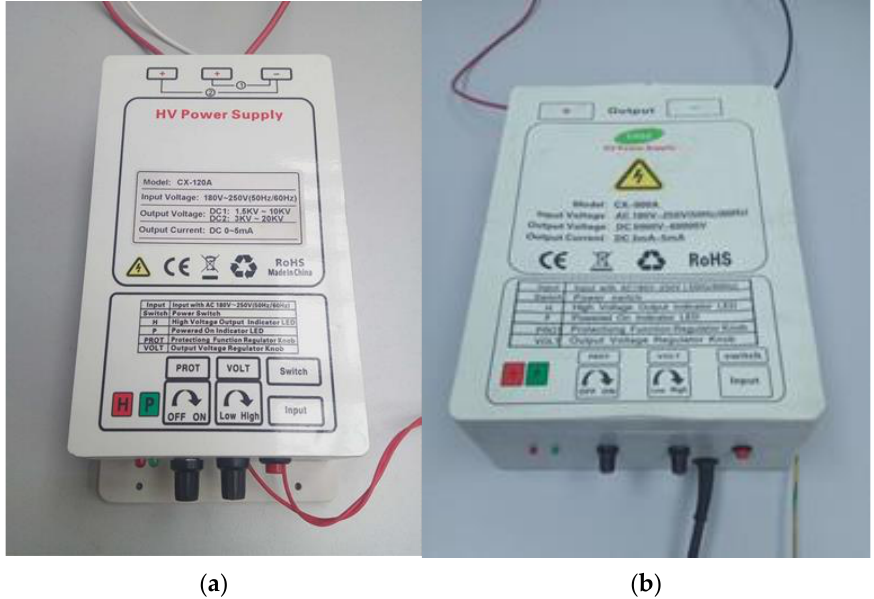
Figure 3. Experimental HV power supply: ( a ) model CX-120A with power 100 W and voltage 20 kV; ( b ) model CX-600A with power and 300 W and voltage 60 kV.